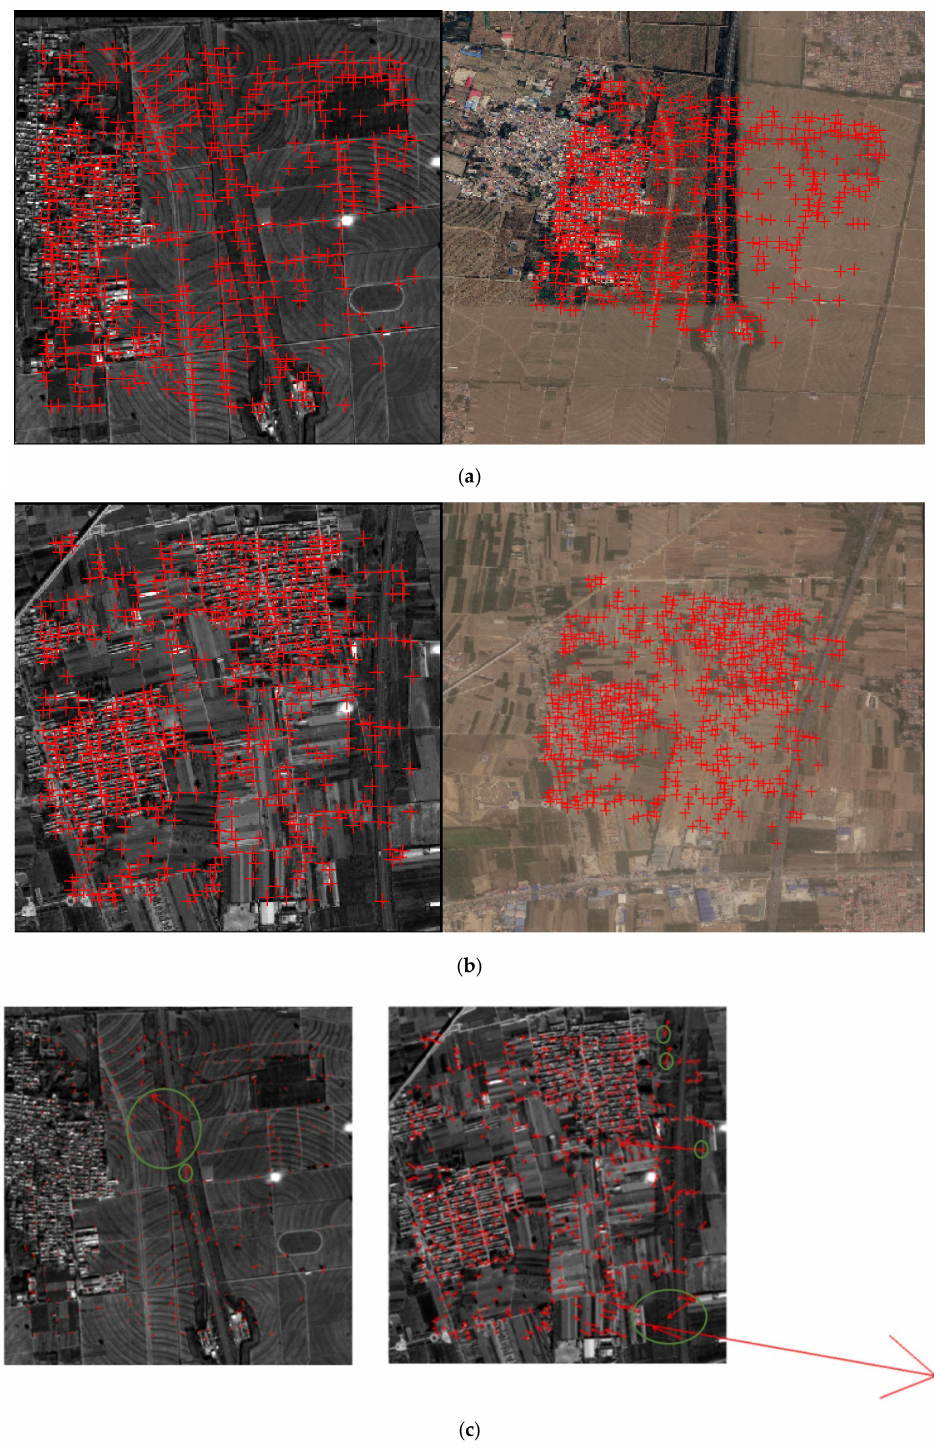
Figure 10. Initial matching results of the PPFPR algorithm. ( a ) 584 matches between image 723 and SuperView-1 DOM. ( b ) 586 matches between image 717 and SuperView-1 DOM. ( c ) Residual distributions of initial matches on images 723 and 717. Through the coarse-to-fine “LPM-SIFT + Phase correlation” matching process, images 717 and 723 obtained 581 and 580 control points, respectively, which were used for single– image geometry calibration. Experiment results in Table 3 show that the RMSE of the dense control points is close to 1/3 pixel in image space, while the RMSE is 0.55 pixel when using 25 manually collected control points. Figure 11a,b show the final matches